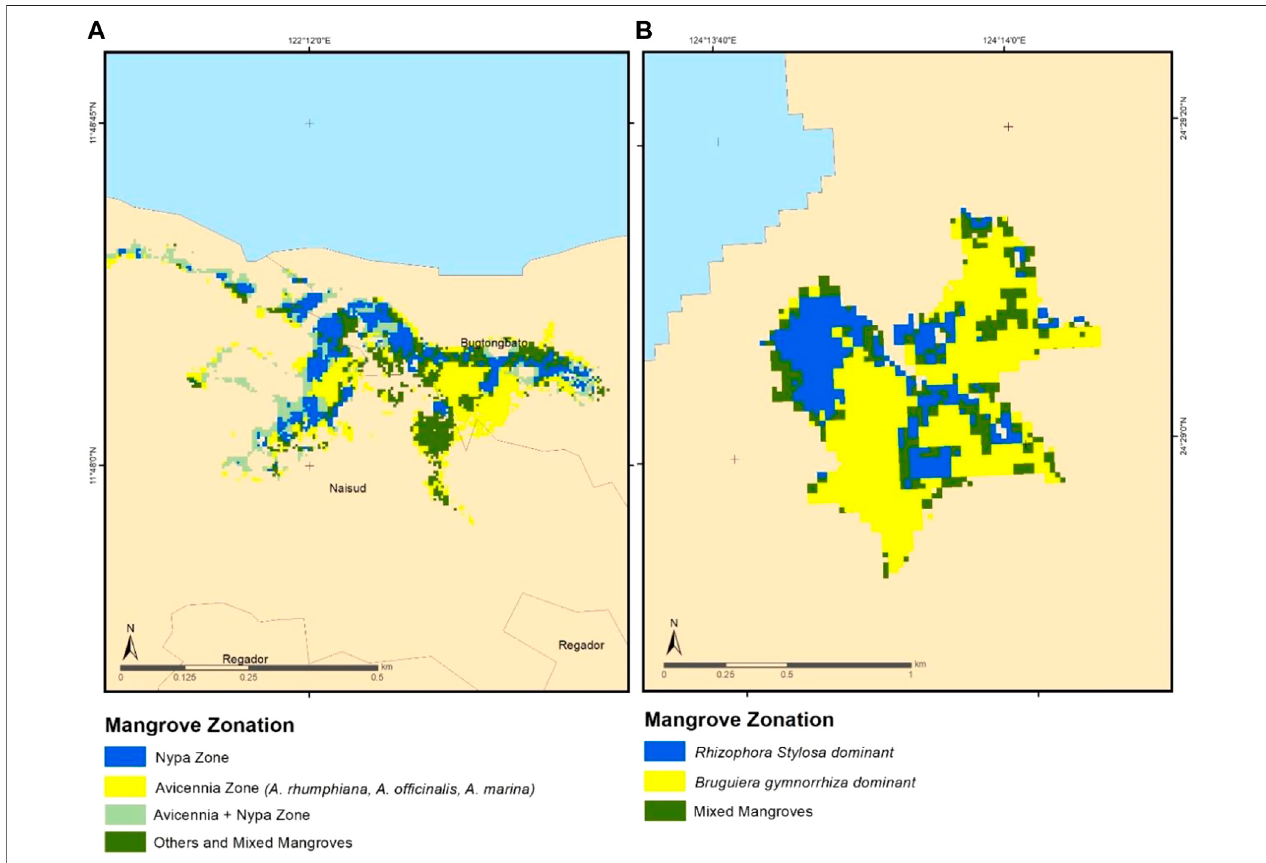
FIGURE 5 | Generated mangrove zonation in Katunggan-It Ibajay (KII, (A) and Fukido Mangrove Park (B) with the corresponding classes identi fi ed. KII was dominated by Nypa and Avicennia zones while the Fukido site was dominated by two speci fi c species of the Rhizophora and Bruguiera genera.